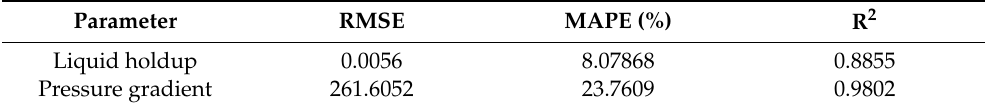
Figure 5. Prediction accuracy of the proposed DNN model: ( a ) liquid holdup and ( b ) pressure gradient. A total of 40 experimental data points, not from within the training and validation data sets, were used to evaluate the prediction performances. Table 4. Prediction accuracy of liquid holdups and pressure gradients with the testing dataset (40